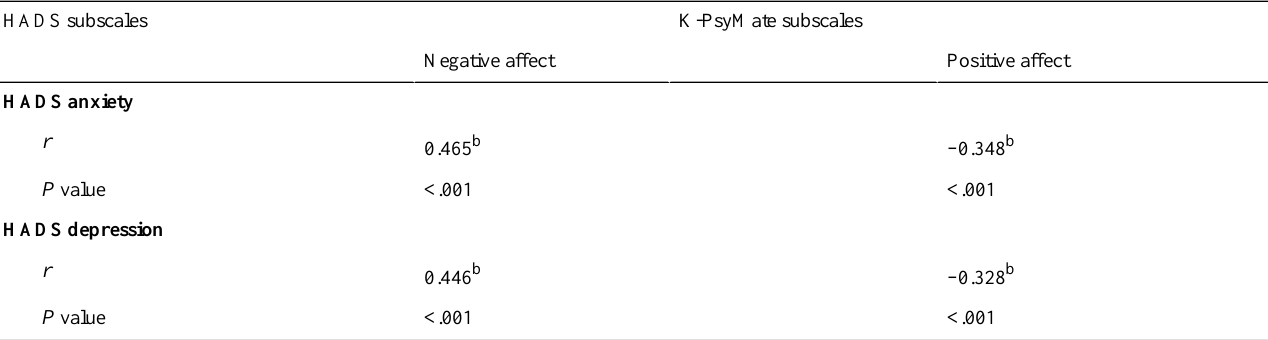
Table 3. Correlations between the K-PsyMate scale and the HADS a